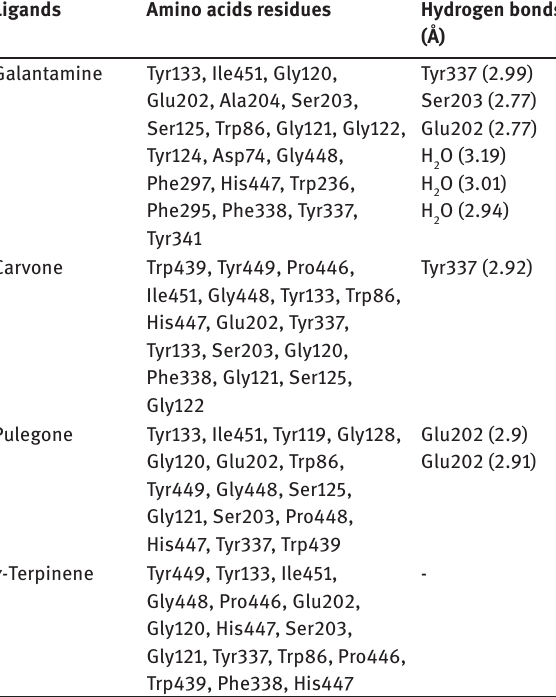
Table 2: Amino acid residues in close contact (4Å) to selected ligands and hydrogen bonds between them. Results obtained for docking simulation with use of MVD with consideration of H molecules in crystal structure of AChE.